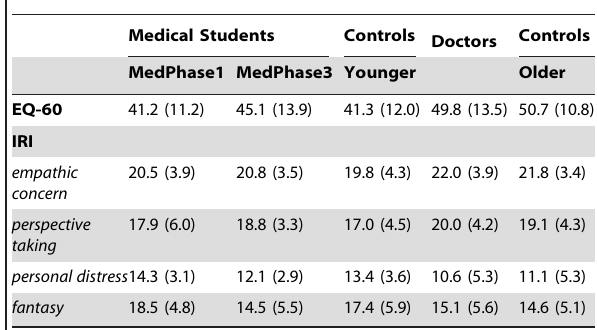
EQ=Empathy Quotient; IRI=Interpersonal Reactivity Index.